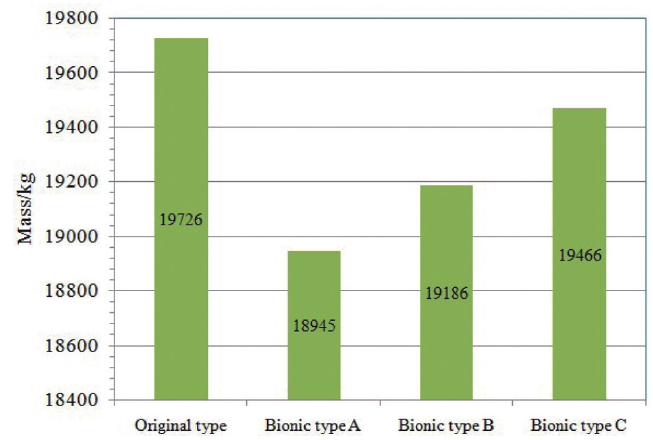
Fig. 12. Columns’ mass